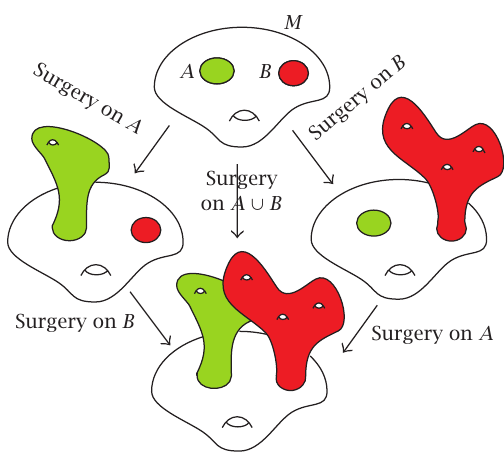
Figure 2.1. Commuting